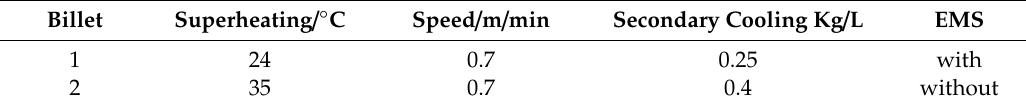
Table 1. The parameters of the continuous casting process of the experimental steel. Billet Superheating / ◦ C Speed / m / min Secondary Cooling Kg / L